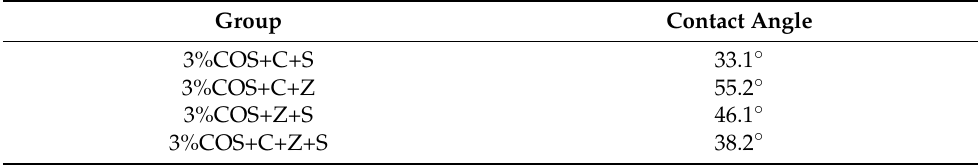
Table 1. Contact angle of nIon 2+ -COS/SA gel